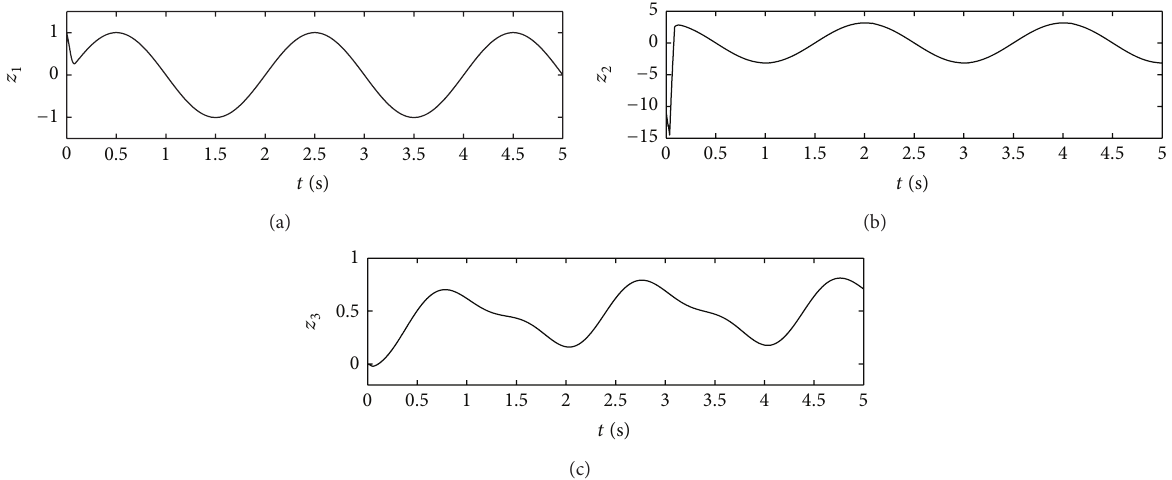
Figure 8: State response of the controlled PMSM in 𝑧